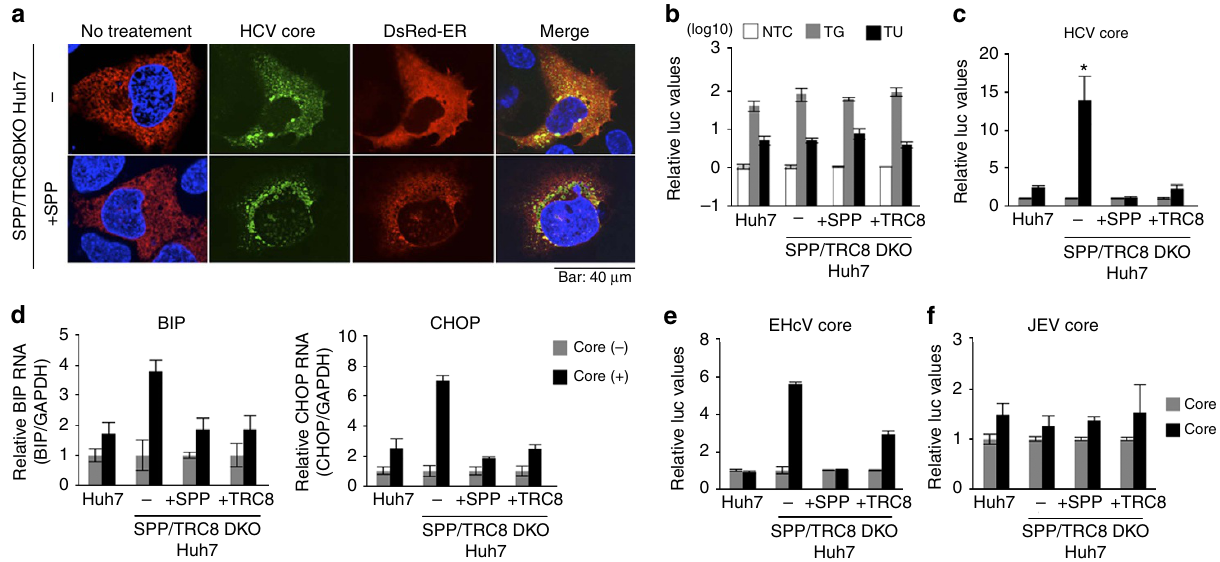
Figure 7 | The HCV core altered the ER distribution and induced ER stress in SPP/TRC8DKO Huh7 cells. ( a ) SPP/TRC8DKO Huh7 cells (bottom) and those stably expressing SPP-HA (top) were transfected with pCAG OSF-HCV core and pCMV DsRed-ER and incubated for 48h. FLAG-HCV core (green) and nuclei (blue) were stained with anti-FLAG antibody and DAPI, respectively. Scale bar, 40 m m. Images are representative of two independent experiments. ( b ) The luciferase activity was determined in cells transfected with a reporter plasmid containing spliced XBP1 (ERAI) and pRL-SV40